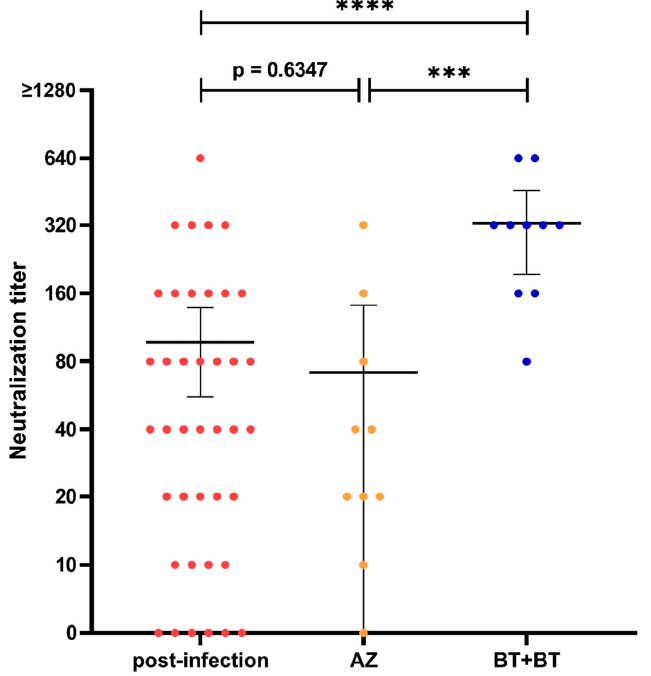
Figure 4. Comparison of neutralization titers of serum samples seven weeks post-infection (red) and five weeks after prime vaccination with AZD1222 (orange) or BNT162b2 (= two weeks after homol- ogous booster vaccination, blue). Abbreviations: AZ = AZD1222, BT = BNT162b2, MO = mRNA- 1273. Significance levels: *** p value < 0.001, **** p value